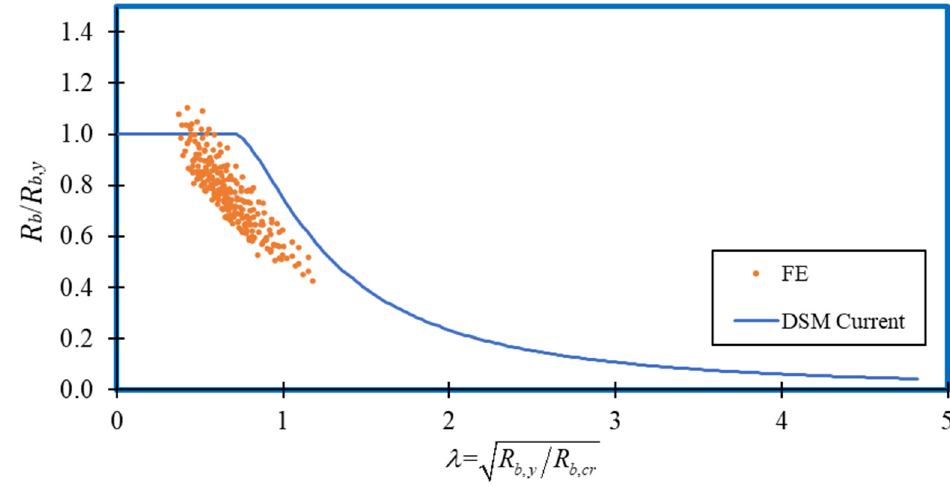
Figure 26. Comparison of parametric results and available DSM equation [22].